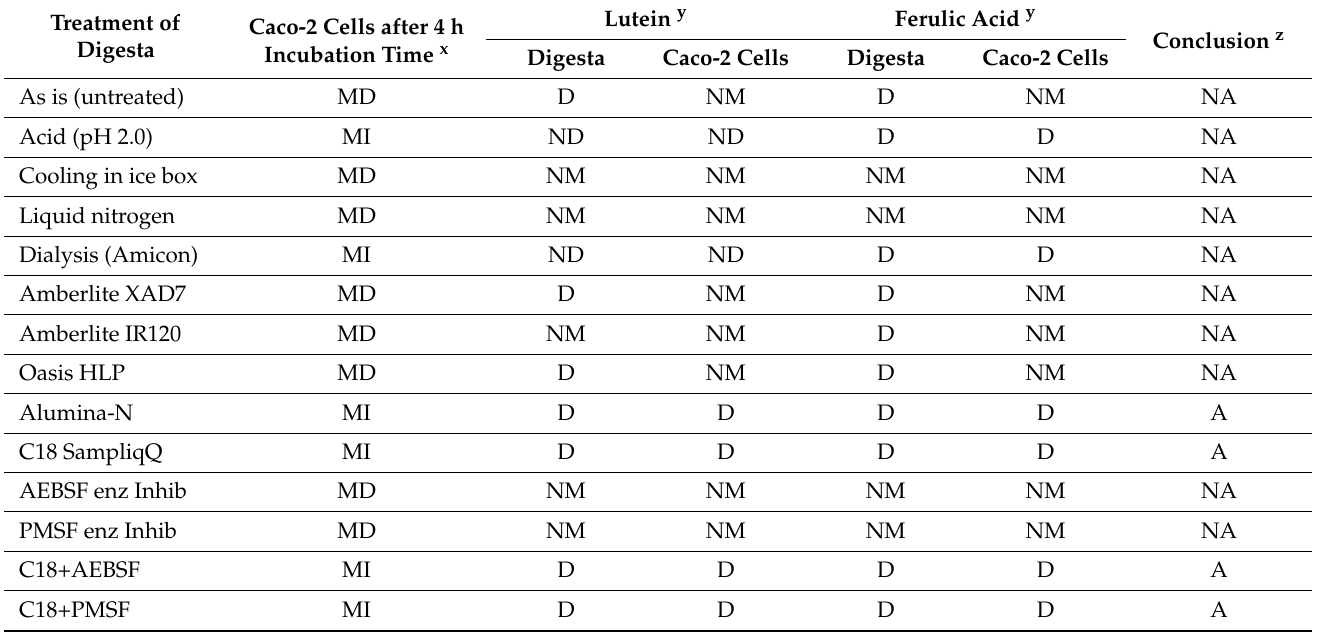
Table 1. Effect of various cleanup treatments of digesta on survival of caco-2 cells and status of lutein and ferulic acid following the simulated gastrointestinal digestion and Caco-2 cell